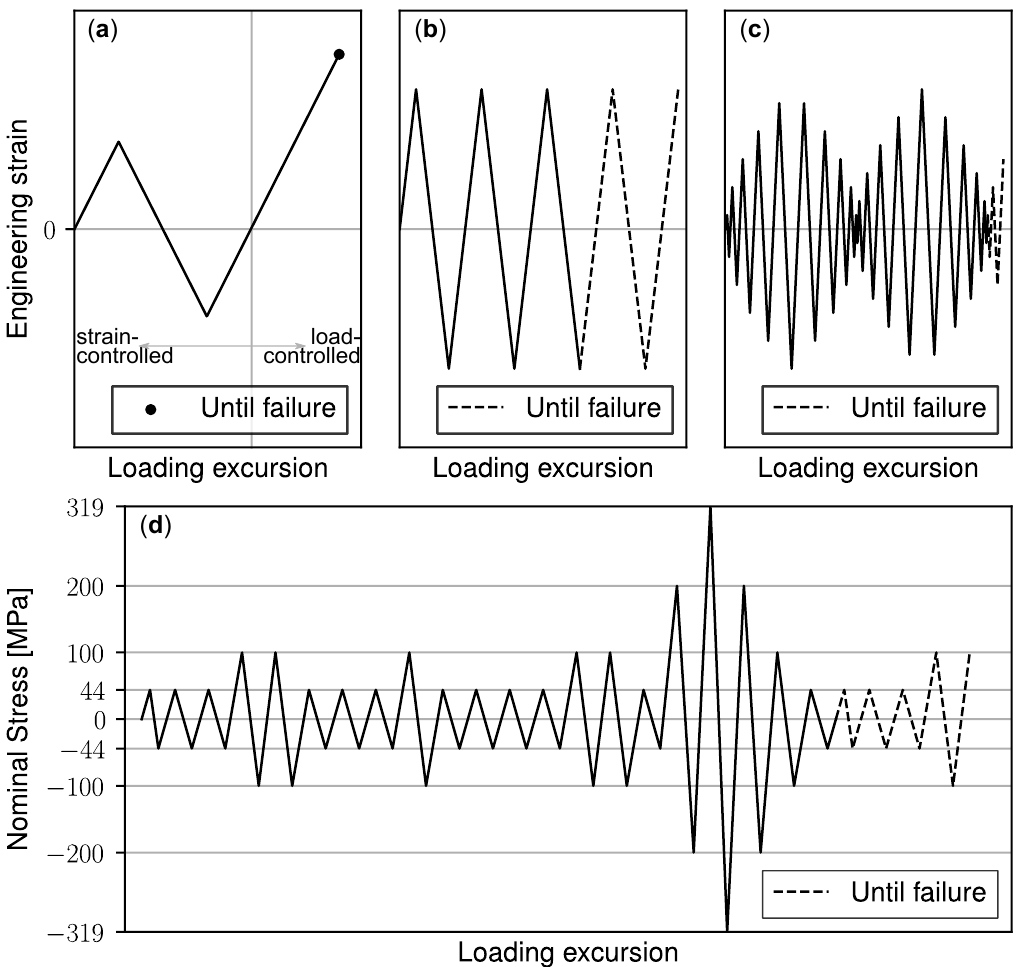
Figure 5. Load profiles for the material parameter estimation experiments and the validation experi- ment: ( a ) one cycle and tension until failure, ( b ) constant amplitude cycling, ( c ) incremental step test, ( d )